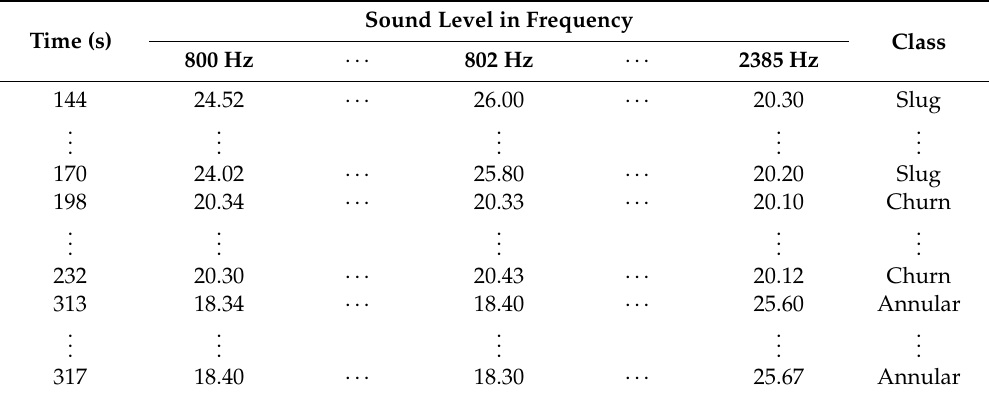
Table 3. Training data for support vector machine.